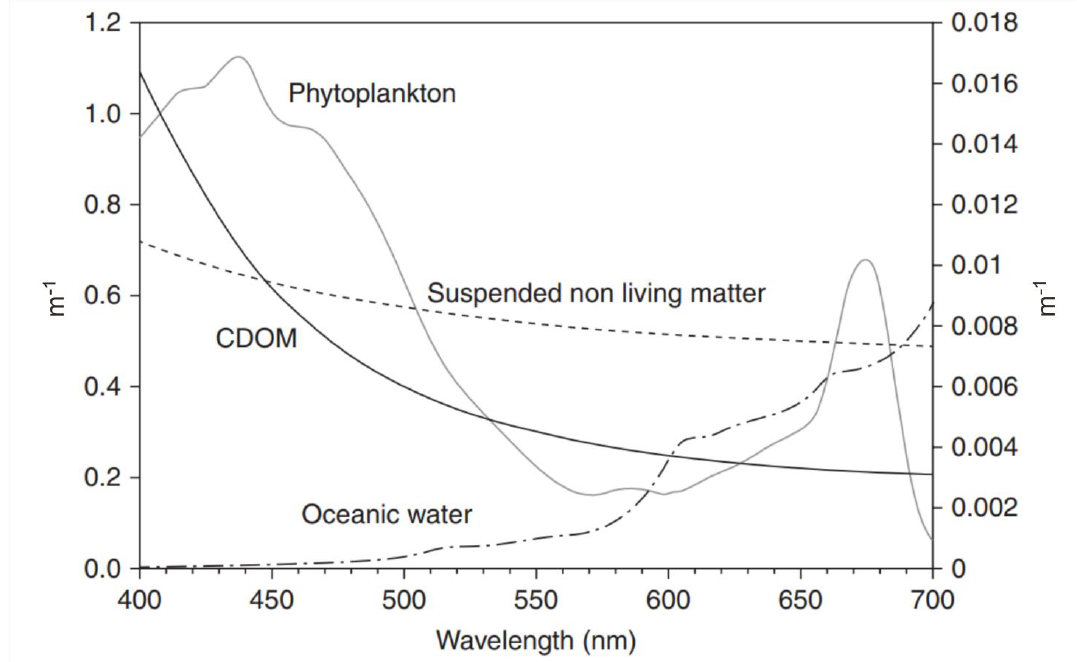
Figure 5. The absorption profiles of four major constituents of natural waters. “Oceanic water” refers to very clear seawater. Colored Dissolved Organic matter (CDOM), oceanic water and suspended non-living matter all use the primary axis; only the phytoplankton spectrum uses the secondary axis. Reprinted from Subsea Optics and Imaging, Johnsen et al., Underwater hyperspectral imagery to create biogeochemical maps of seafloor properties, 508-535. Copyright (2013), with permission from Elsevier. [52] .